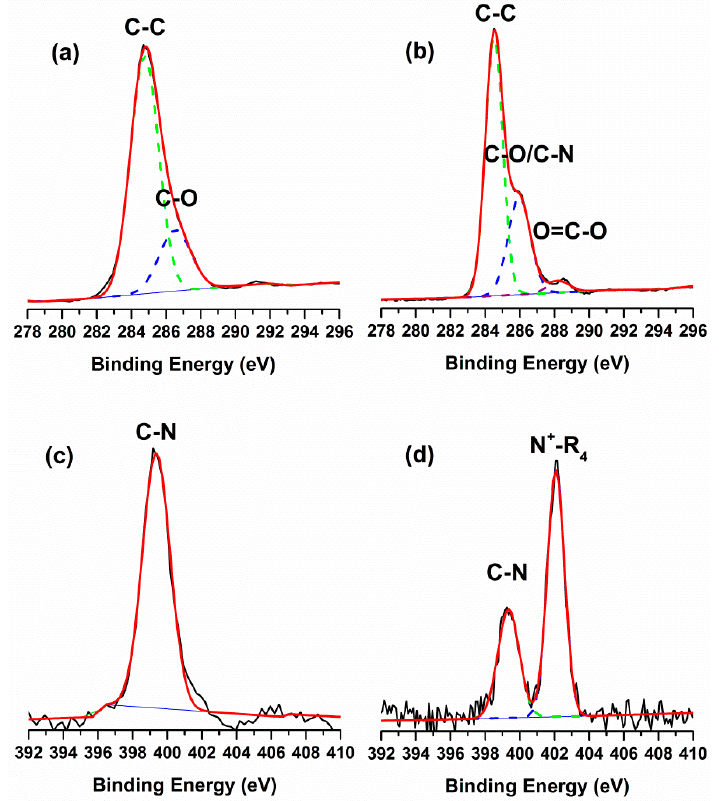
Table 1. Element composition obtained by XPS and the grafting amount of the original and modified PES membranes.